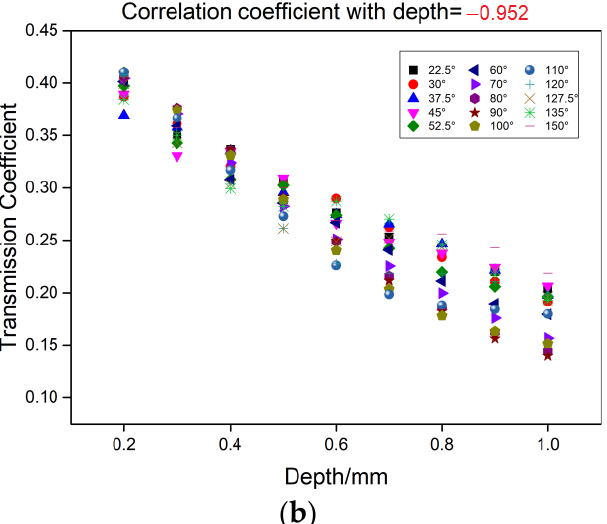
Figure 13. ( a ) Scatter plot of the root mean squares of reflected waves. ( b ) Scatter plot of transmission coefficients.